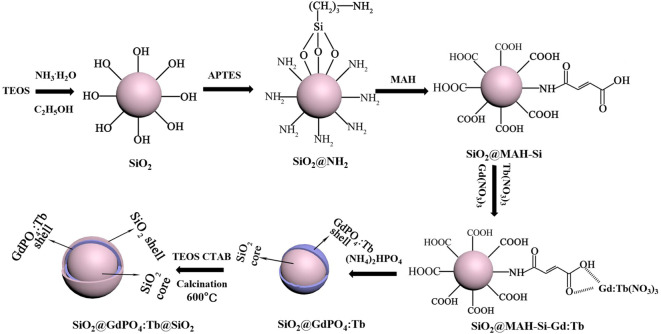
Schematic illustration showing the formation mechanism of core-shell-shell structured SiO2@GdPO4:Tb@SiO2.